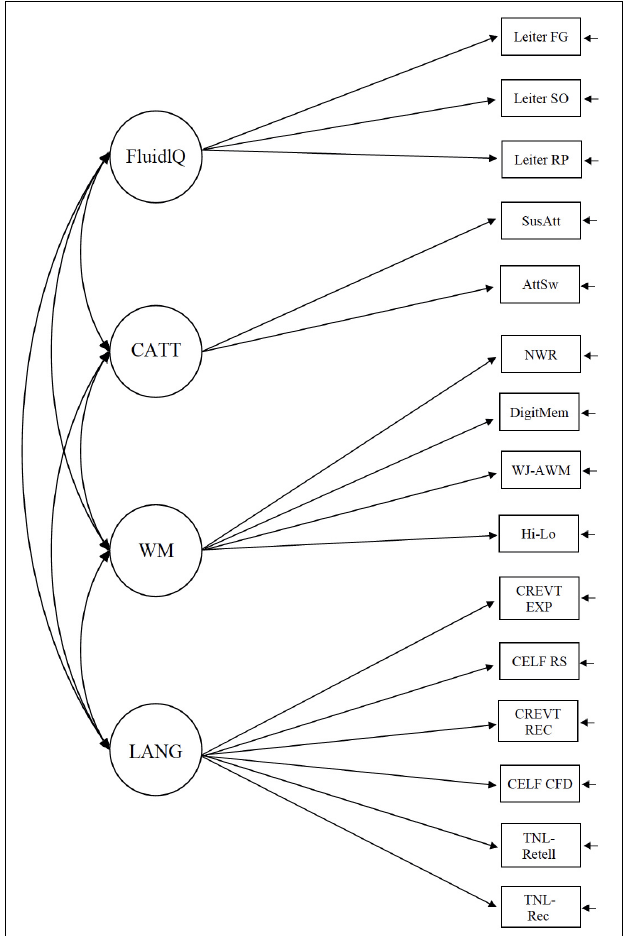
FIGURE 2 | A four-factor conceptual model in which the LTM-LK measures were embedded in the language latent variable.